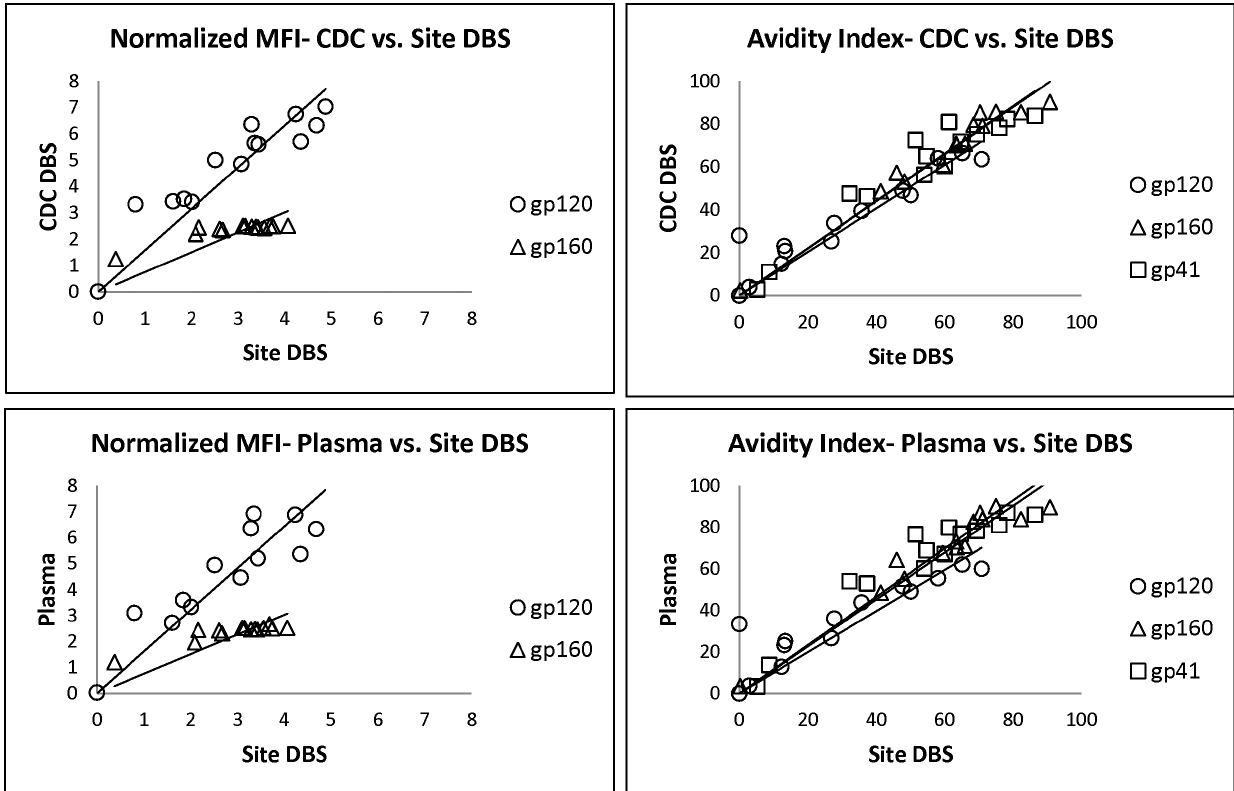
Figure 2. CDC versus field DBS. The normalized MFI values and avidity index were compared for CDC versus field-prepared DBS. The solid lines represent the linear trend